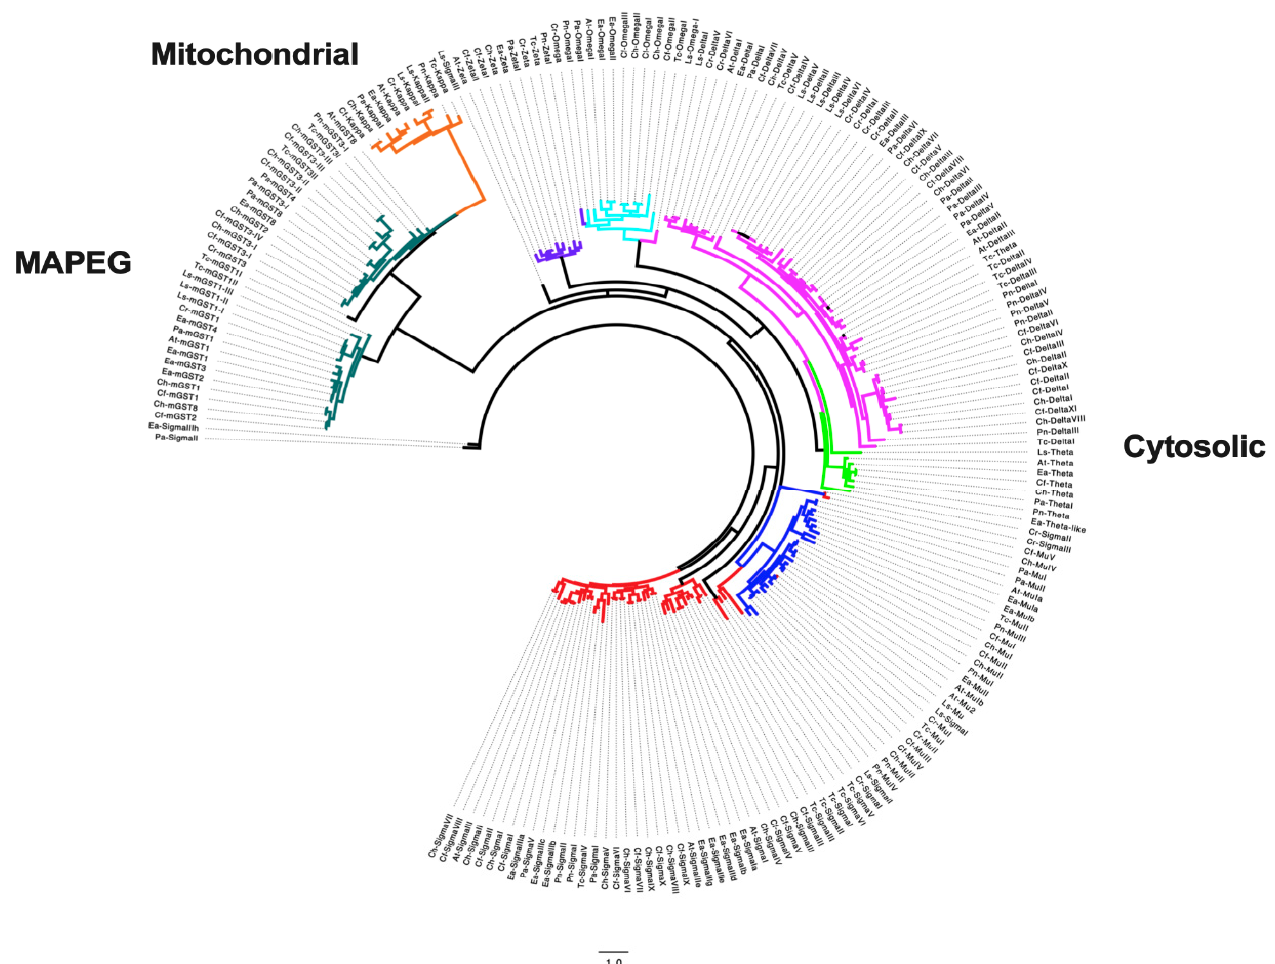
Figure 3. Phylogenetic tree for the glutathione S-transferases in marine copepods. The unrooted tree shows the relationships between the cytosolic, microsomal (MAPEG), and mitochondrial GSTs from the copepods C. finmarchicus , C. helgolandicus , P. annandalei , A. tonsa , E. affinis , T. californicus , T. japonicus , P. nana , C. rogercressereyi , and L. salmonis . FAST TREE was used to build maximum-likelihood phylogenetic tree using the protein evolution model JTT + CAT. Color coding: teal = microsomal (MAPEG), orange = mitochondrial, red = sigma, blue = mu, light green = theta, pink = delta, turquoise = omega, purple = zeta.